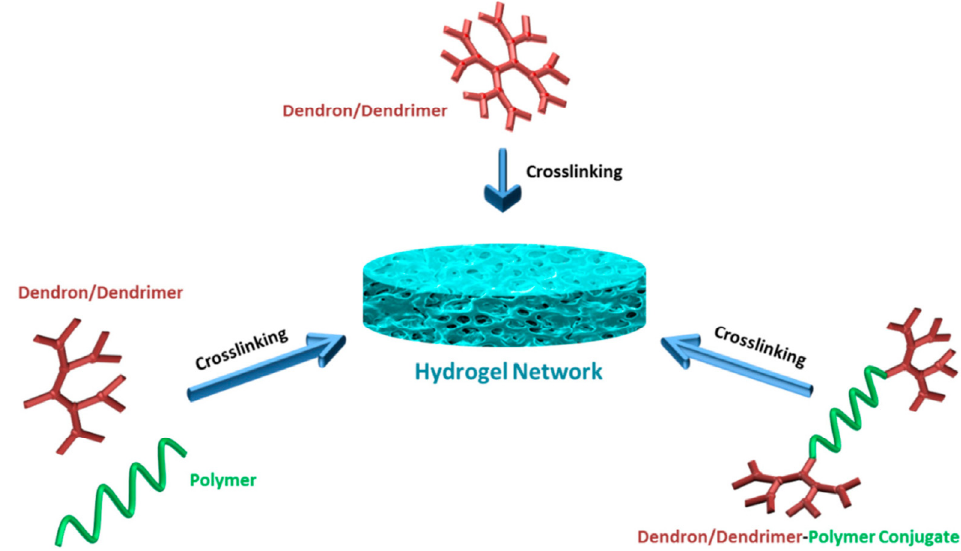
Figure 7. Approaches toward the fabrication of hydrogels using dendron- and dendrimer-based building blocks. Reproduced under creative commons license from [139].